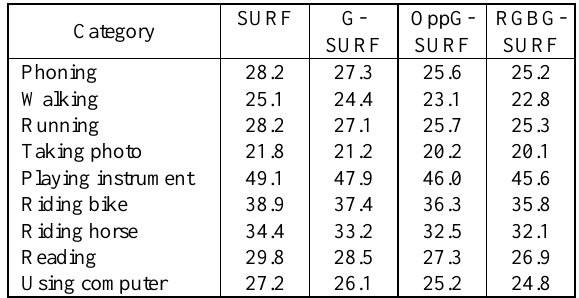
Playing instrument